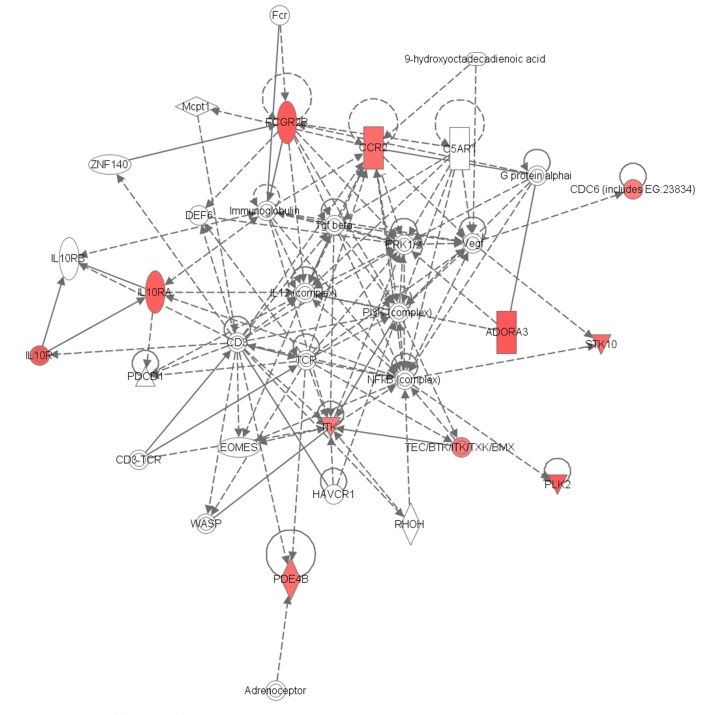
Differentially expressed genes between CSP and PPP kidneys with prolonged CIT.Eighteen probe sets were differentially expressed when CIT was higher than 1,200 minutes and not significant between groups (CSP vs. PPP). Pathway Analysis showed that almost all these genes belong to the same network (score 23) and associate with the inflammatory response and immune cell trafficking.